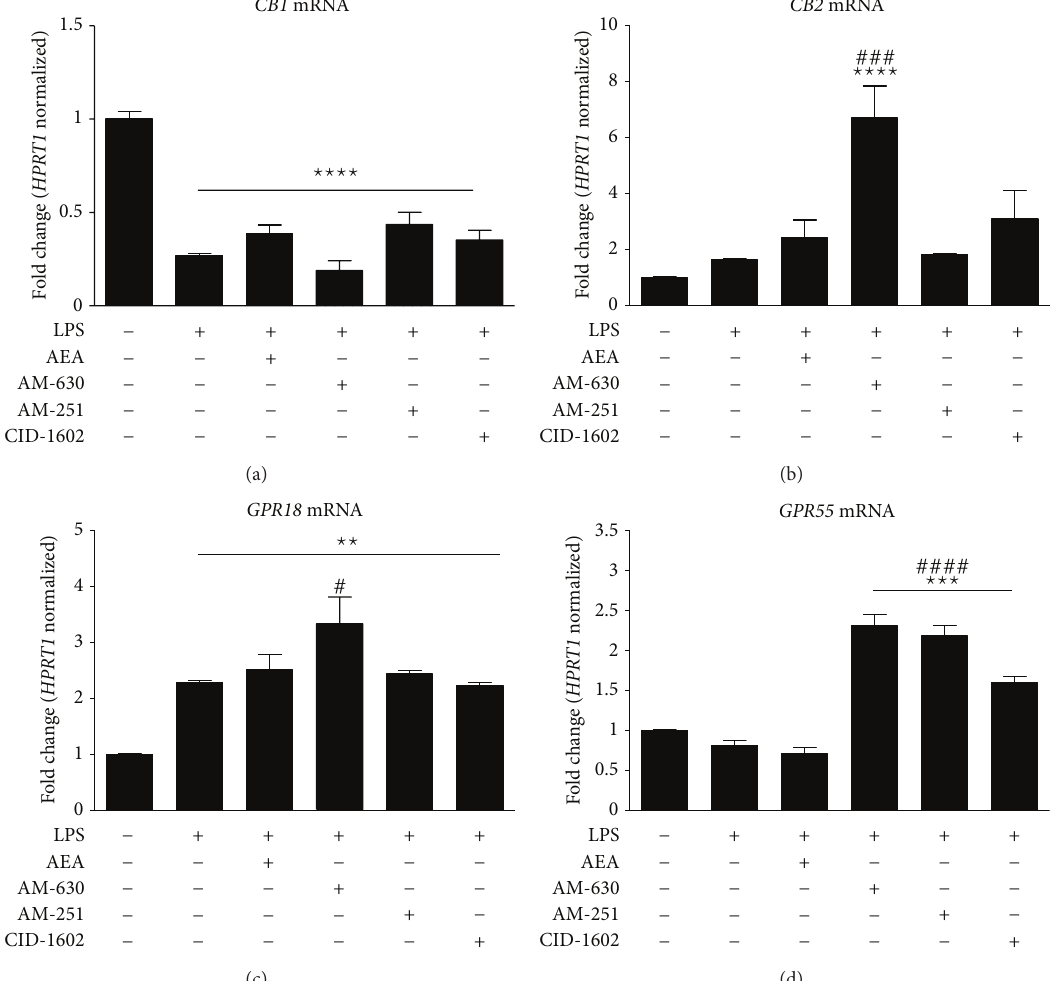
Figure 3: Expression of CB1, CB2, GPR55, and GPR18 transcripts in rat primary microglial cultures in the presence of the tested compounds. Samples were analyzed 24 hours after the stimulation of cells with LPS. Data are presented as the mean ± SEM and represent the normalized averages derived from 6 to 8 samples per group. The results are presented as the fold-change normalized to the expression of the reference gene Hprt1 and were calculated relative to nonstimulated cells. Statistical analysis was performed using one-way ANOVA followed by Bonferroni post hoc tests; 𝑃 values < 0.05 were considered significant. * It denotes a significant difference versus the nonstimulated control; #, versus the LPS-stimulated